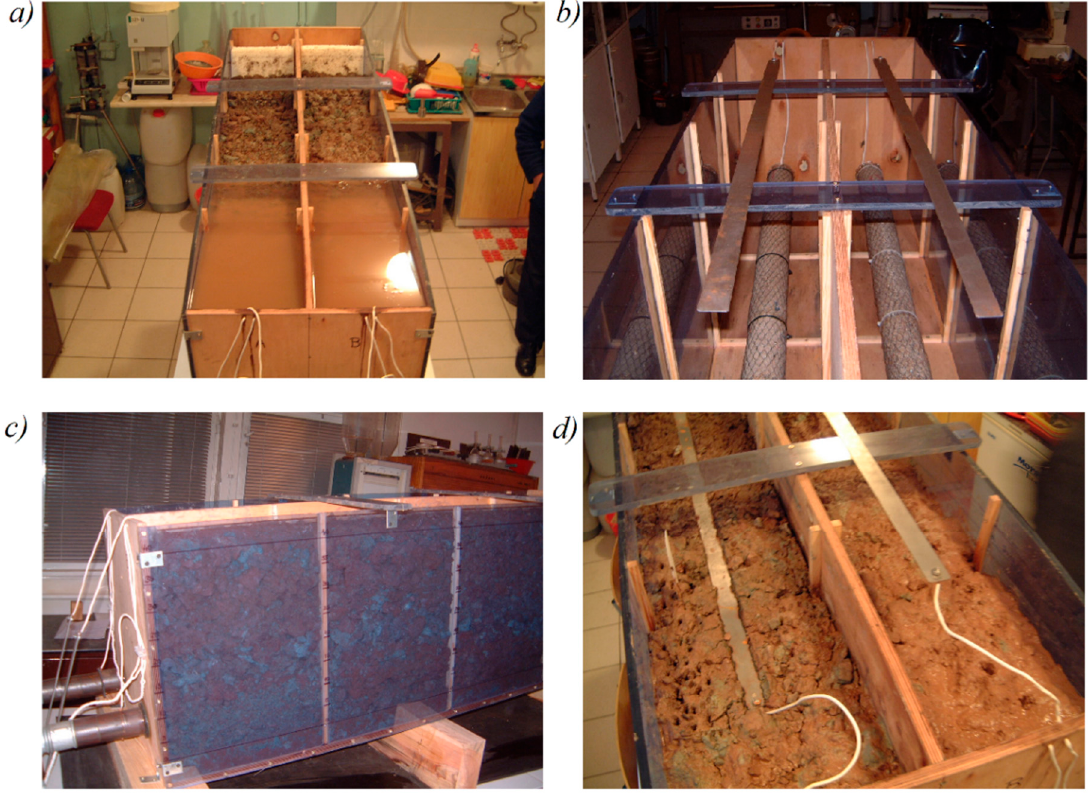
Figure 6. The test stand for conducting model tests: ( a ) two-chamber tank, ( b ) upper electrodes A(+) and lower electrodes K(-), ( c ) soil in the chamber after compaction, ( d ) the effect of ET application visible in the left chamber.